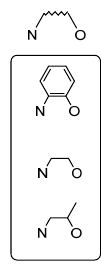
Figure 2. Preliminary studied MoO 2 L structures.